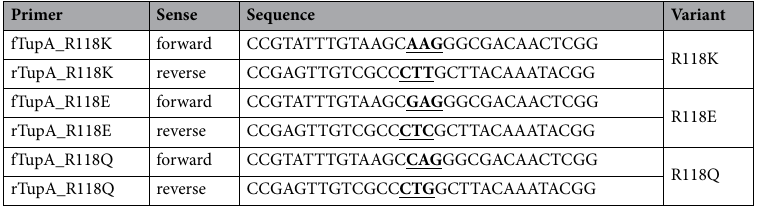
Table 3. Primers used to mutate the R118